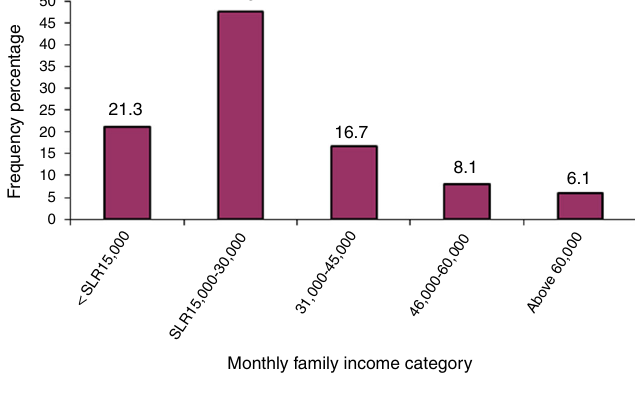
Figure 2. Employment status as a frequency percentage